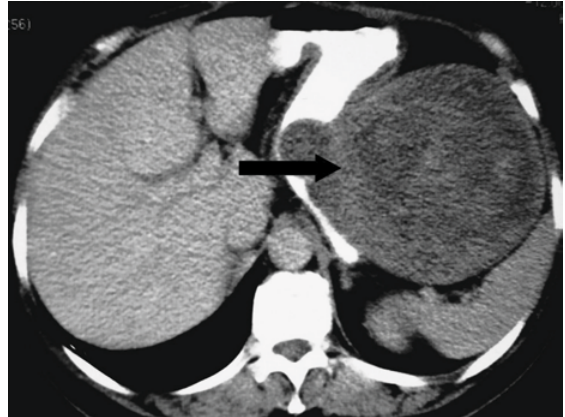
Figure 1. Contrast-enhanced abdominal CT scan showing intra- abdominal soft-tissue mass (Black arrow).